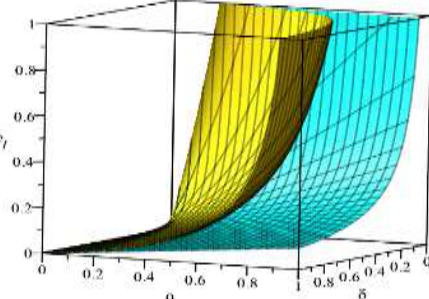
Figure 5. The e ff ect of manufacturer’s behavior θ , δ on the green index of logistics networks.